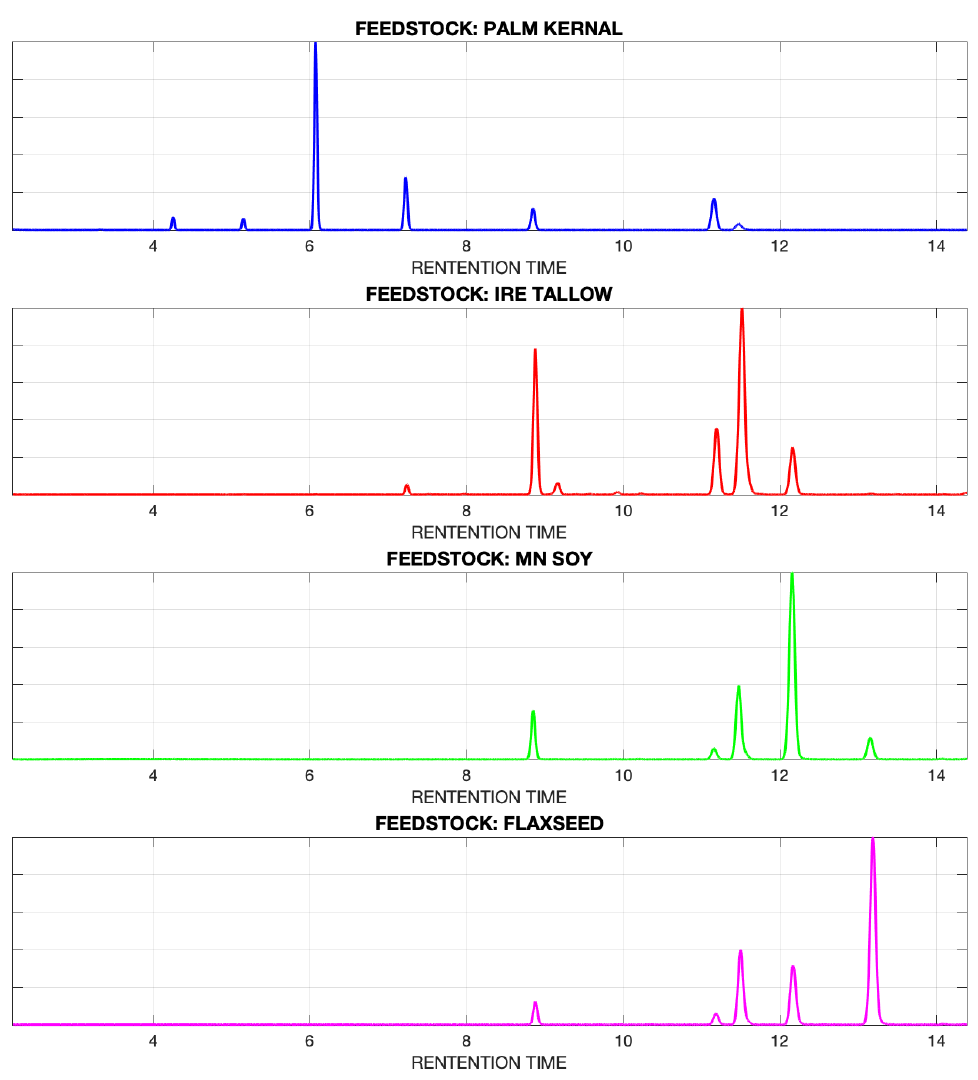
Figure 3. Stacked chromatograms of a B100 biodiesel for various feedstock types using DB-FFAP (shorter, thinner film column). Each chromatogram has been normalized to its maximum value for